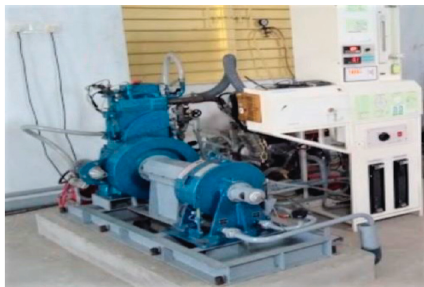
Figure 1: Experimental setup.